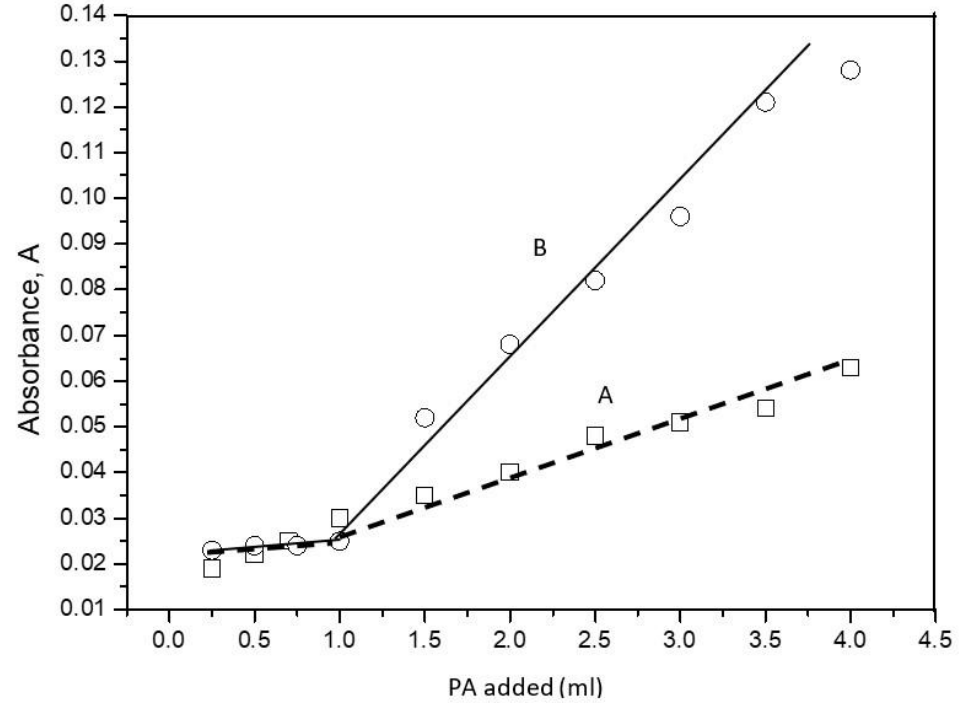
Figure 2. Absorption curve of CT complex: ( A ) absorption maximum of PA, ChA, and DDQ; ( B ) absorption maximum of PA-ChA and PA-DDQ complexes; and ( C ) expanded spectra shown at 400 – 650 nm for PA-ChA and PA-DDQ complexes (all spectra were taken in acetonitrile).